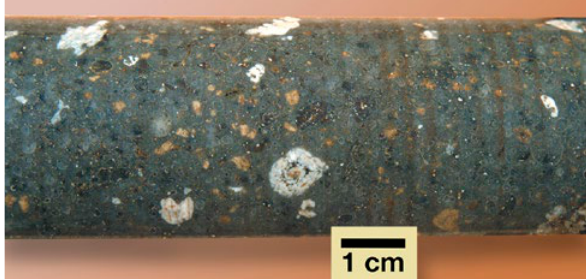
Figure 70. Syneresis shrinkage in coarse porphyroid from Wagga Tank, NSW, may indicate associated ore.